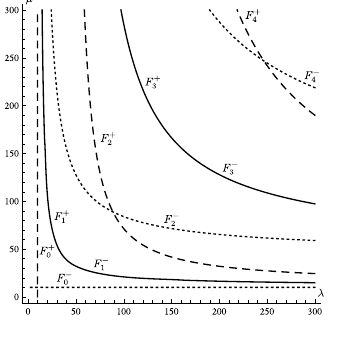
Figure 1. The Fuˇc´ık spectrum. Figure 2. “Good” regions shaded; light shaded for solutions with 2 n − 1 zeros in (0 , 1), dark shaded for solutions with 2 n zeros in (0 , 1), n = 1 , 2 ,... ; “bad” regions